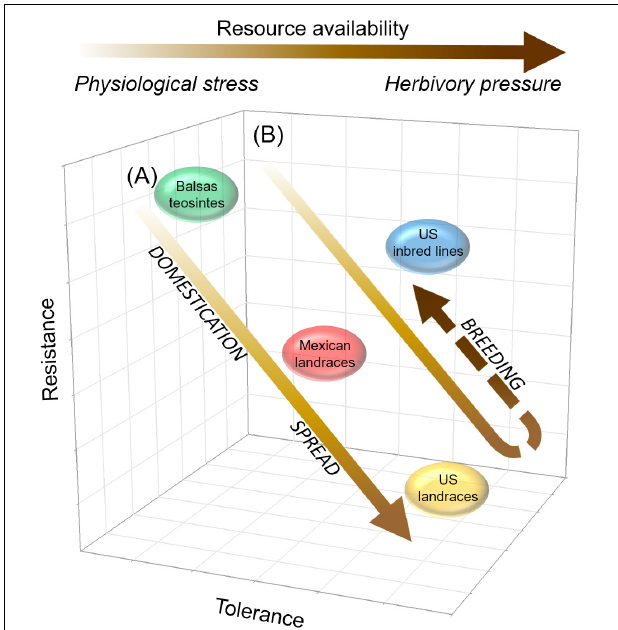
FIGURE 8 | Hypothesized relationship between plant tolerance and resistance in maize, as mediated by agricultural intensification, resource availability, and environmental stress. In this study’s context, agricultural intensification refers to widespread cultivation of high-yielding maize cultivars developed through systematic breeding, under the umbrella of chemical inputs, particularly commercial insecticides and synthetic fertilizers, and under increasing WCR pressure (see Text for additional details). The high-yielding cultivars are hybrids generated from inbred lines, which require chemical fertilizers (and adequate moisture) and pesticides to reach maximum productivity. The prior, pre-intensification period is characterized by widespread cultivation of landrace maize, natural and farmer (artificial) selection of landraces for broad resistance to environmental stresses, absence of fertilizers and pesticides, and minimal WCR pressure. (A) Prior to agricultural intensification, resistance to WCR gradually decreases while tolerance increases with maize domestication and spread, as resource availability increases, and as physiological stress gradually loses relevance to defense strategy evolution. (B) The trend of WCR resistance loss with WCR tolerance gain is reversed with breeding under agricultural intensification, where resource availability is high, physiological stress is minimized with the advent of chemical fertilizers, and WCR pressure becomes relevant to defense strategy evolution, though its relevance is mediated by insecticide use. In arrows in both (A,B), and in horizontal arrow at top of figure, the lighter to darker gradient in coloration indicates an increasing gradient of resource availability; within this gradient, physiological stress and herbivory pressure are most relevant to defense strategy evolution at the low- and high-resource availability extremes,